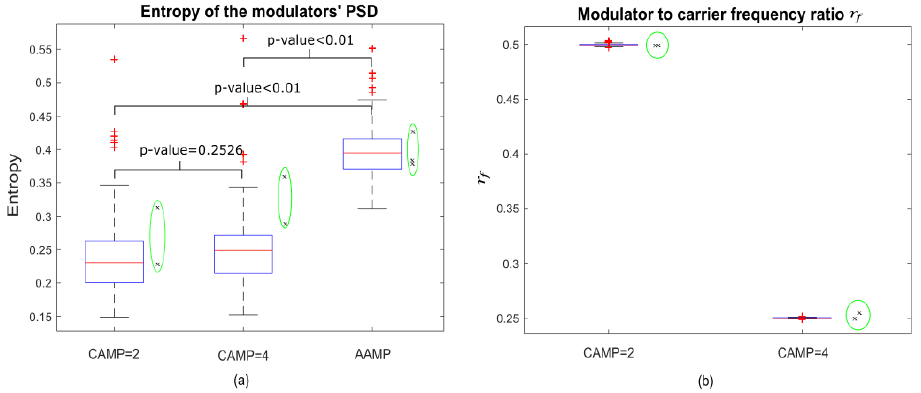
Figure 8. Features used for distinguishing the subtypes of synthetic vocal fry GAWs: ( a ) entropy of the modulators’ power spectral density (PSD) for distinguishing cyclically vs. acyclically modulated vocal fry and ( b ) modulator-to-carrier frequency ratio 𝑟 𝑓 to distinguish CAMP = 2 and CAMP = 4 type vocal fry GAWs. The features of natural GAWs are represented using”x” encircled in green.